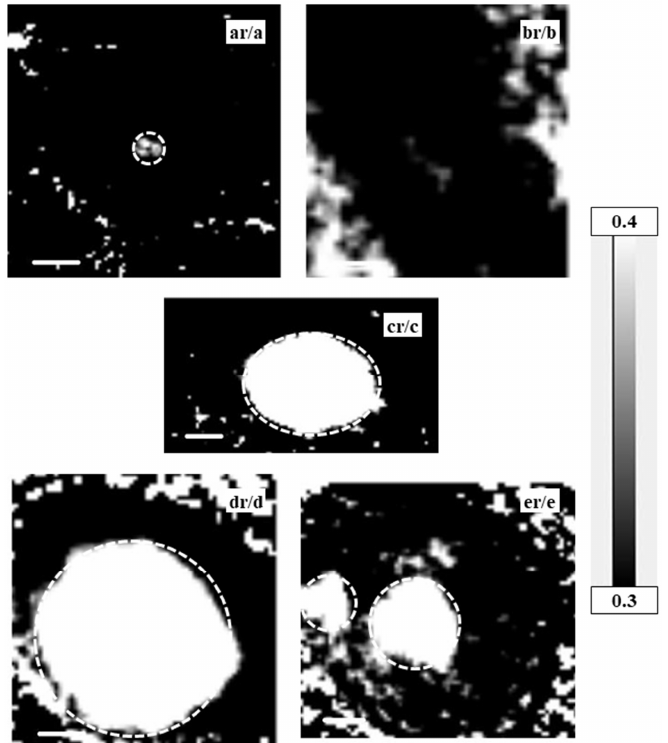
Figure 4. Ratio images of each residual-to-observed image pair shown in Figures 2 and 3. Each residual image (spect3) was divided by the absorbed image (spect1) for ( ar / a ) the CHO cell; ( br / b ) the chromosome; ( cr / c ) the HeLa S3 cell; ( dr / d ) the isolated nucleus; and ( er / e ) the apoptotic nucleus. Grayscale on the right indicates the residual-to-absorbed image OD ratio of residual image to absorbed image for values higher than 0.3. Scale bars are 5 μm ( ar / a ), 0.5 μm ( br / b ), 2 μm ( cr / c ), and 1 μm ( dr / d and er / e ). Areas possibly unreliable for analysis are indicated with dashed circles.